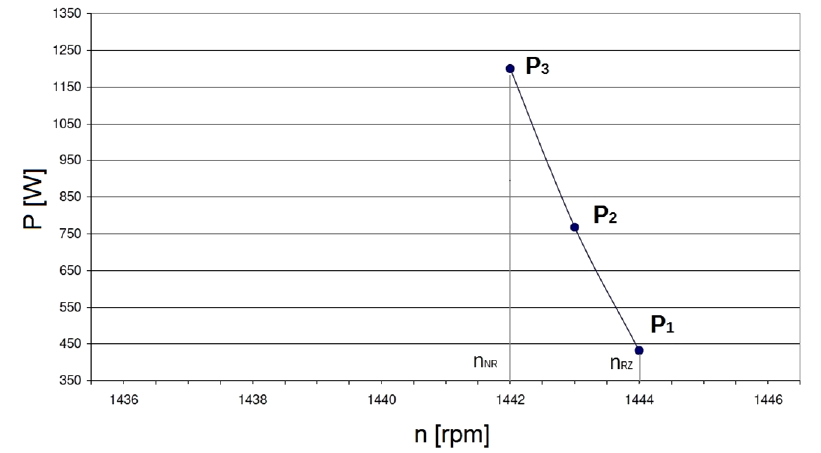
Fig. 4. The characteristic – regulator load variation of Farymann Diesel engine type D10 as a function of crankshaft rotational speed used during testing (variable fuel dose per engine cycle at crankshaft rotational speed stabilized by the regulator), n NR – rotational speed regulator setting, n RZ – real rotational